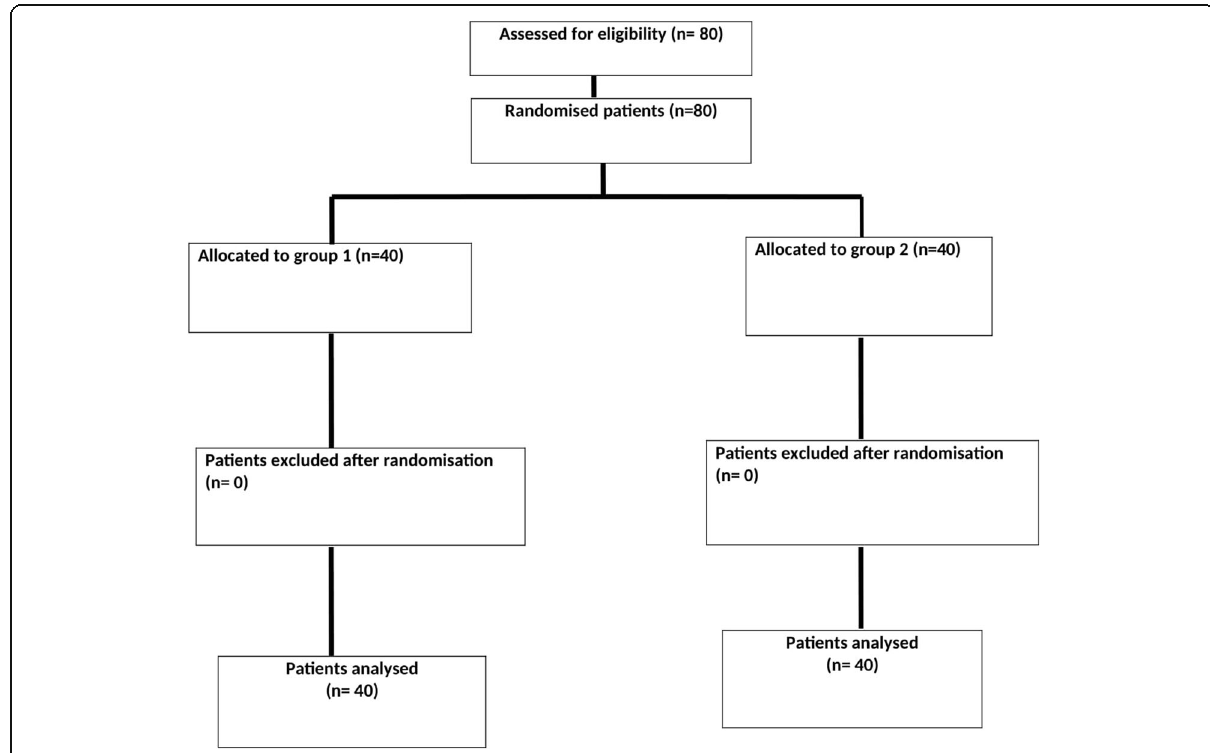
Fig. 1 CONSORT (Consolidated Standards of Reporting Trials) flow diagram showing patients recruited, randomized, and